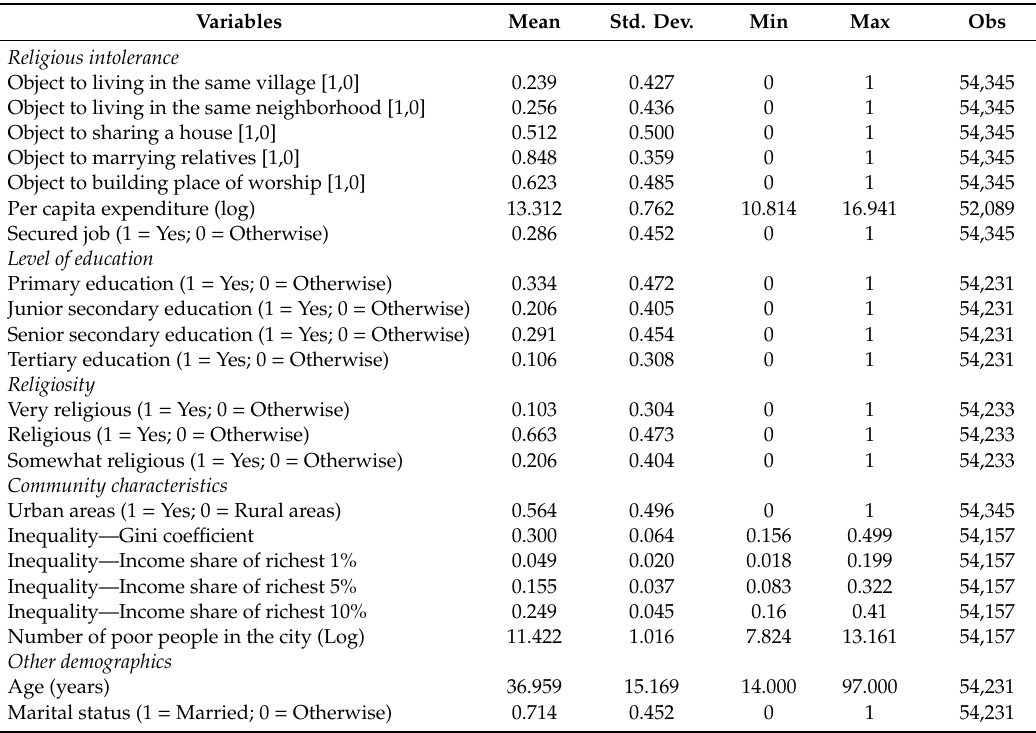
Table 1. Summary statistics of variables used in the regression analysis.